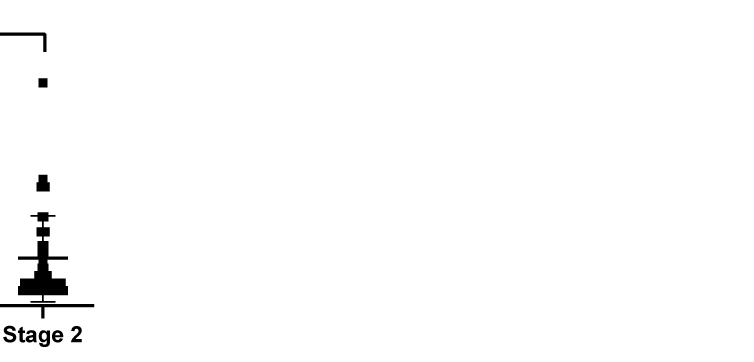
Figure 1. The time profile ( A ) and distribution ( B ) of recurrence events in the two periods.